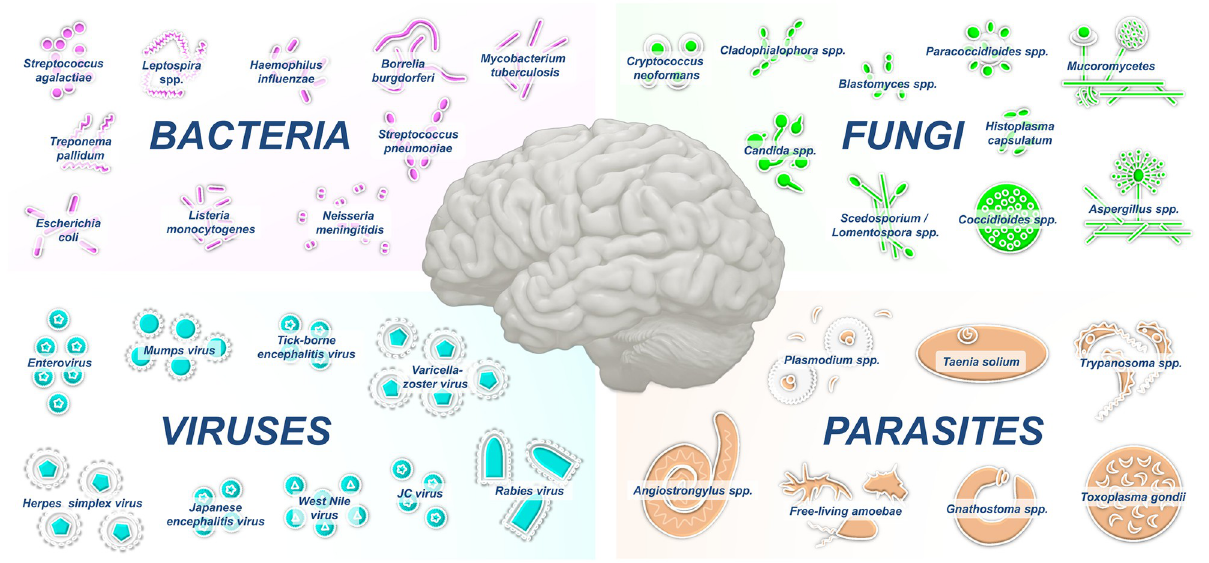
Fig 1. Compilation of prominent bacteria, fungi, viruses, and parasites that infect the CNS. C AU : AbbreviationlistshavebeencompiledforthoseusedthroughoutFig 1 andTable 1 : Pleaseverifythatallentriesarecorrect : NS, central nervous system.